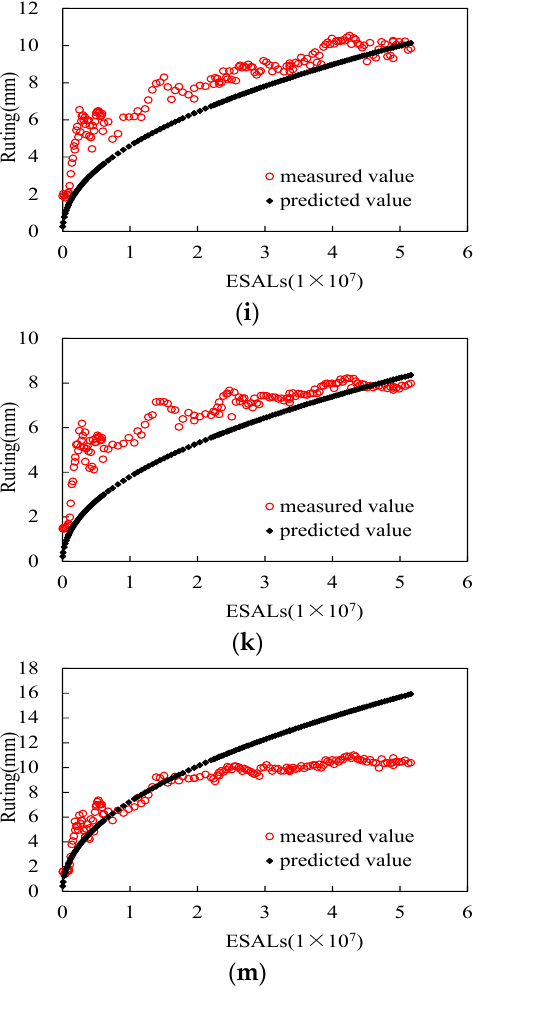
Figure 6. Comparison between the predicted value of the model and the measured value. ( a ) Struc- ture I-STR1. ( b ) Structure I-STR2. ( c ) Structure II-STR4. ( d ) Structure II-STR5. ( e ) Structure III-STR7. ( f ) Structure III-STR8. ( g ) Structure IV-STR10. ( h ) Structure IV-STR12. ( i ) Structure V-STR11. ( j ) Structure V-STR13. ( k ) Structure VI-STR16. ( l ) Structure VI-STR17. ( m ) Structure VII-STR18. ( n ) Structure VII-STR19. Table 2. Error between the predicted value of the rutting model and the measured value. Structure